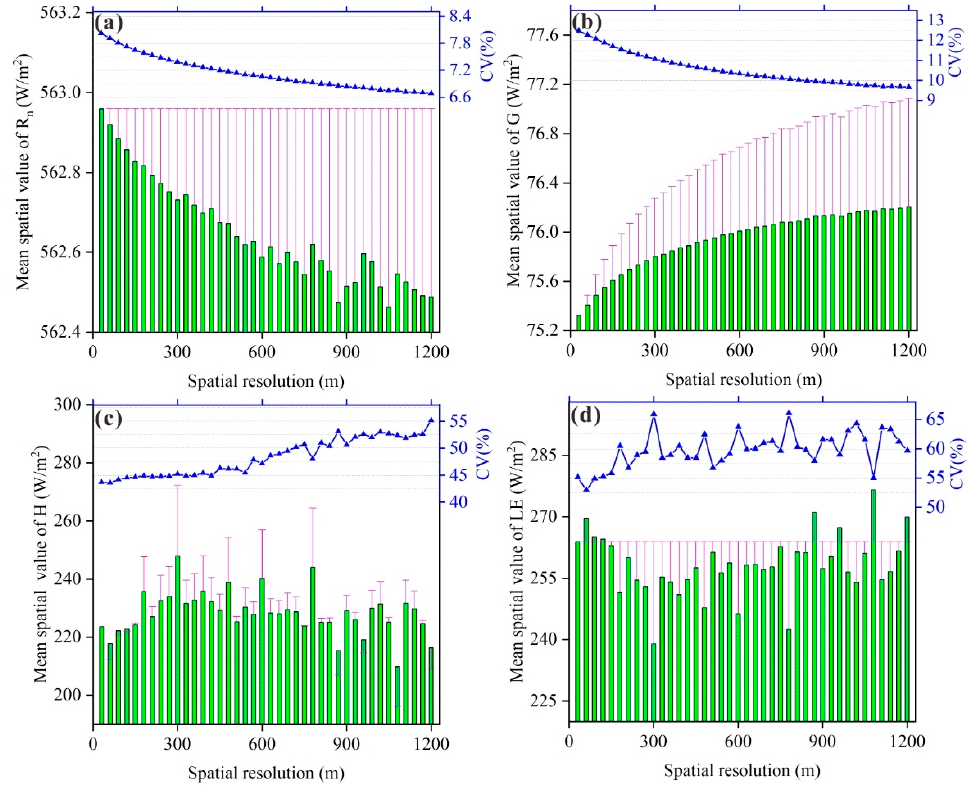
Figure 7. Statistical characteristics of the spatial means and spatial heterogeneity of the fluxes cal- culated at different aggregation levels: ( a ) net radiation flux; ( b ) soil heat flux; ( c ) sensible heat flux; and ( d ) latent heat flux (the green bars represent the spatial mean of different resolutions, the pink lines represent errors compared to the initial resolution (30 m), and the blue lines represent the coefficient of variation).